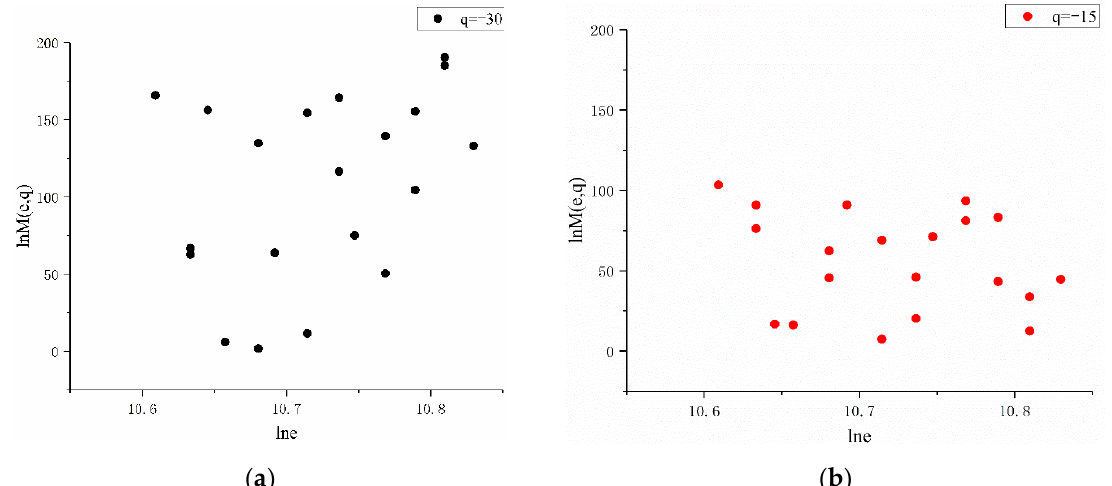
Figure A2. The relationship of ln 𝑀(𝑒, 𝑞) and ln 𝑒 in the Fenhe River Basin. ( a ) The relationship of ln 𝑀(𝑒, 𝑞) and ln 𝑒 when e is [40,000, 50,000] and q is −3 0; ( b ) The relationship of ln 𝑀(𝑒, 𝑞) and ln 𝑒 when e is [40,000, 50,000] and q is − 15.